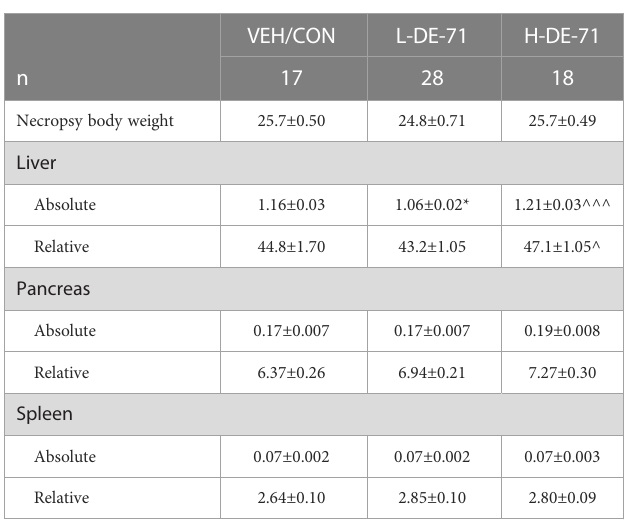
TABLE 1 Body and select organ weights in de-71 exposed male